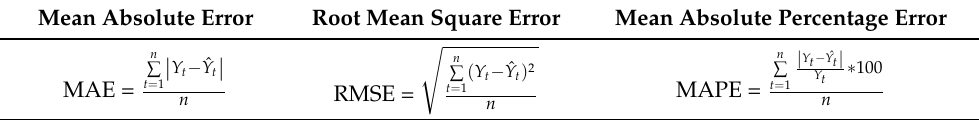
Table 4. Forecast errors